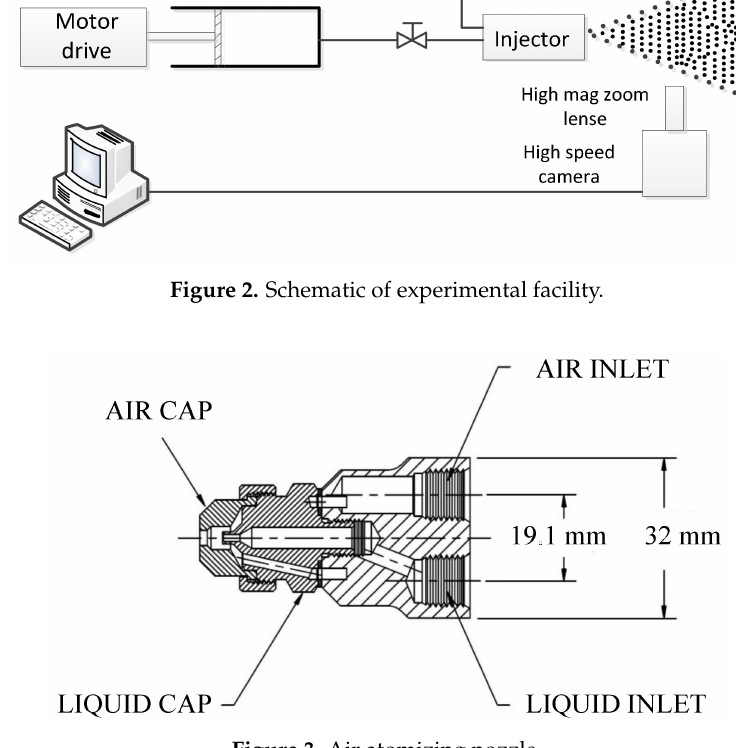
Figure 3. Air atomizing nozzle.